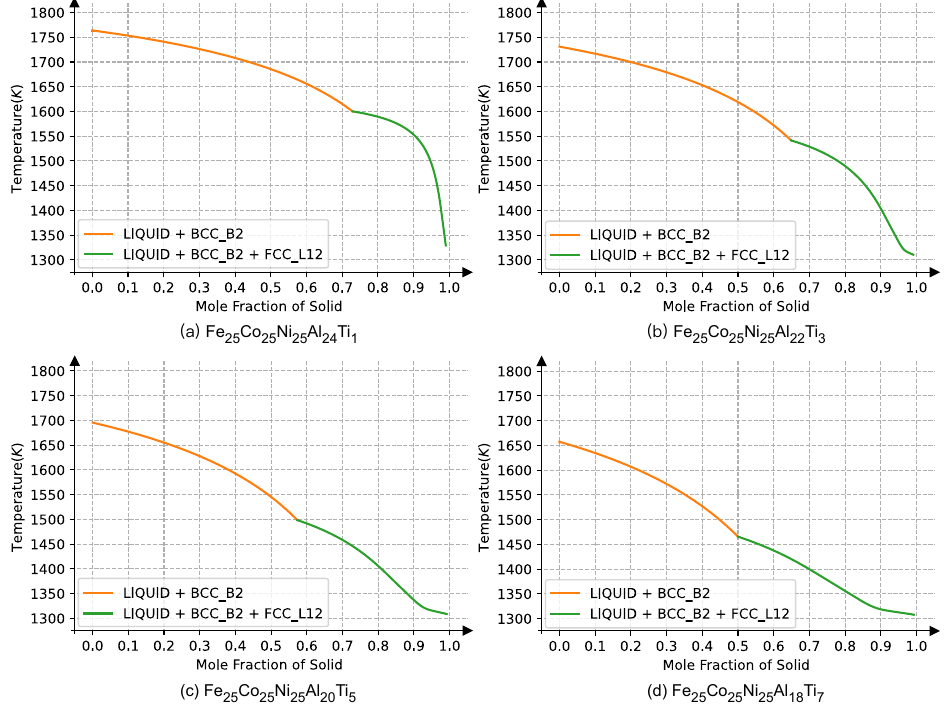
Figure 11. The solidification of the equal-atomic Co 25 Fe 25 Ni 25 Al 25 − x Ti x alloy. Here, Ti is substituted for the content of a quarter Al in Co 25 Fe 25 Ni 25 Al 25 − x Ti x